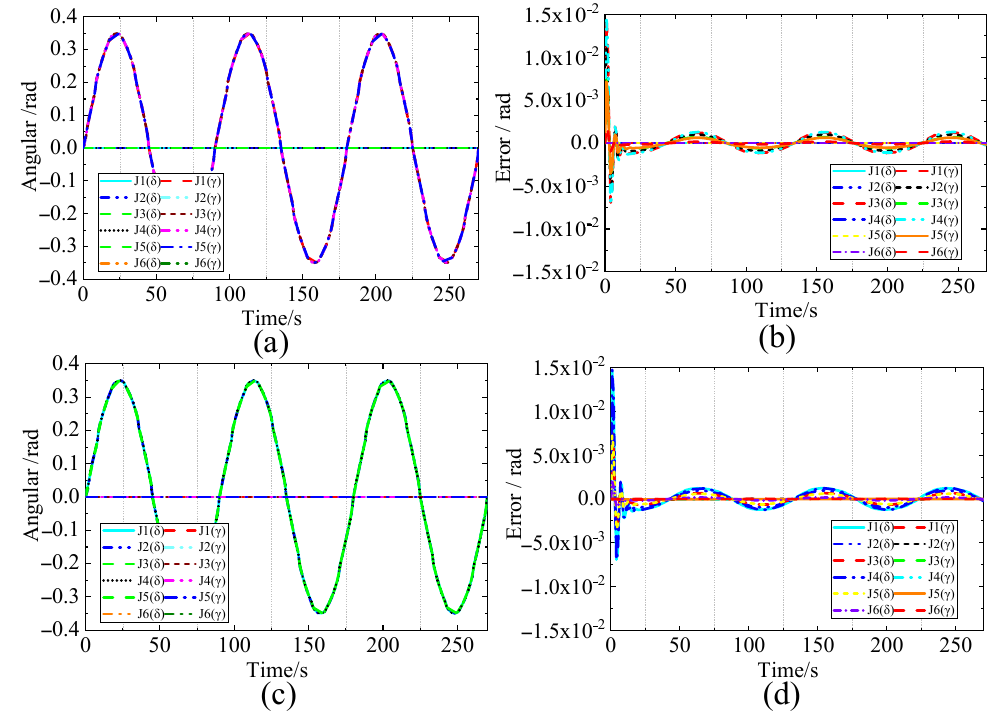
Figure 10. Simulation analysis of the controller. ( a , b ) Vertical sinusoidal trajectory and error and ( c , d ) horizontal sinusoidal trajectory and error.